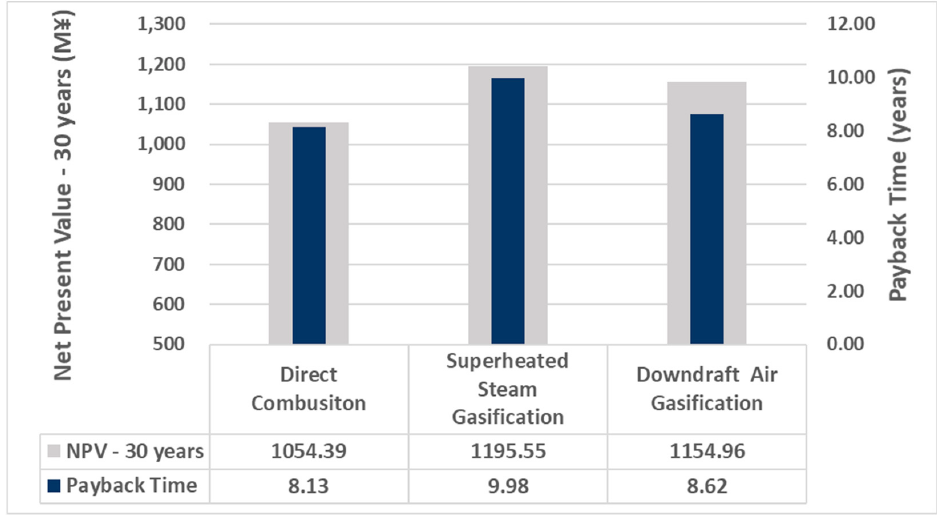
Figure 8. Comparison of three waste-to-energy techniques from an economic perspective.